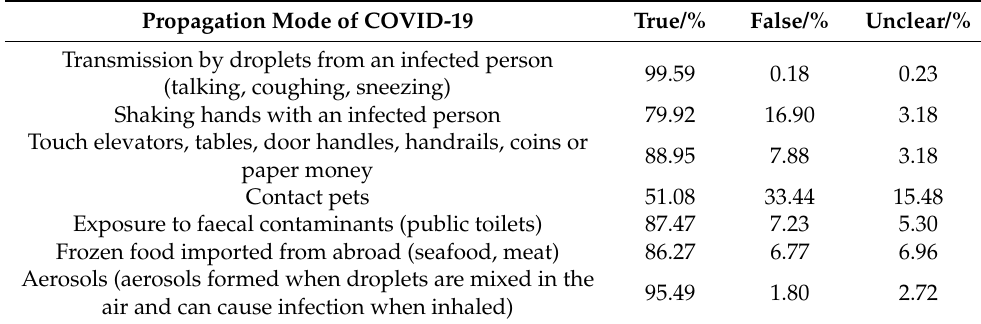
Table 3. Participants’ responses to the mode of transmission of